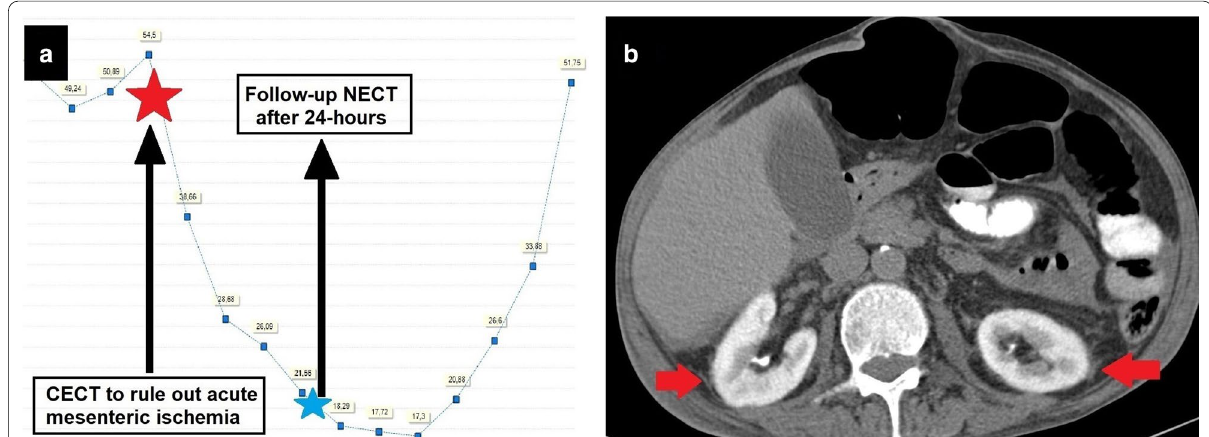
Fig. 14 A complication developing under ideal conditions. A 64-year-old female patient with suspected sepsis was suffering from severe abdominal pain disproportionate to the clinical examination findings. Abdominal CECT was ordered to rule out “mesenteric vascular disease” after explaining all the risks of the procedure (including contrast-induced nephropathy) to the patient. Before the procedure, the glomerular filtration rate (GFR) was 54.5 ml/min/1.73 m2. After CECT, a progressive decline of GFR was observed. When the periprocedural GFR values were evaluated, it was clearly understood that contrast-induced nephropathy had developed ( a ). Follow-up NECT 24 h after the first examination revealed contrast retention of kidneys due to impaired filtration functions (red arrows, b )